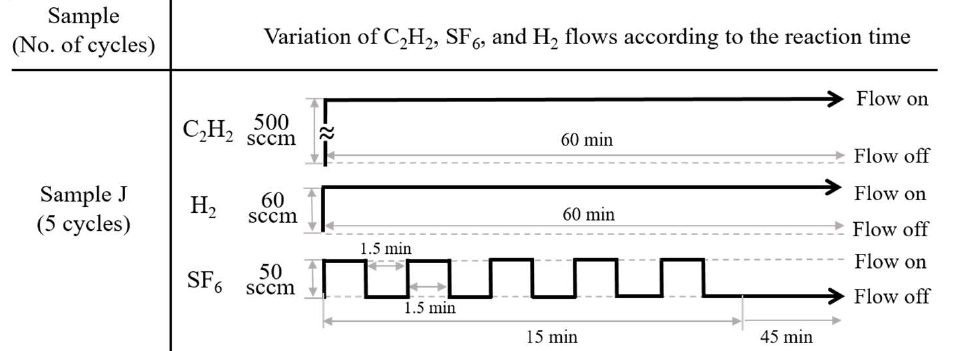
Figure 10. The production of heating film: ( a ) the coating equipment used to perform the gravure method and ( b ) the actual gravure coating process of carbon paste on the base film. A single des-HF film was composed of eight different functional individual thin films, as shown in Figure 11.